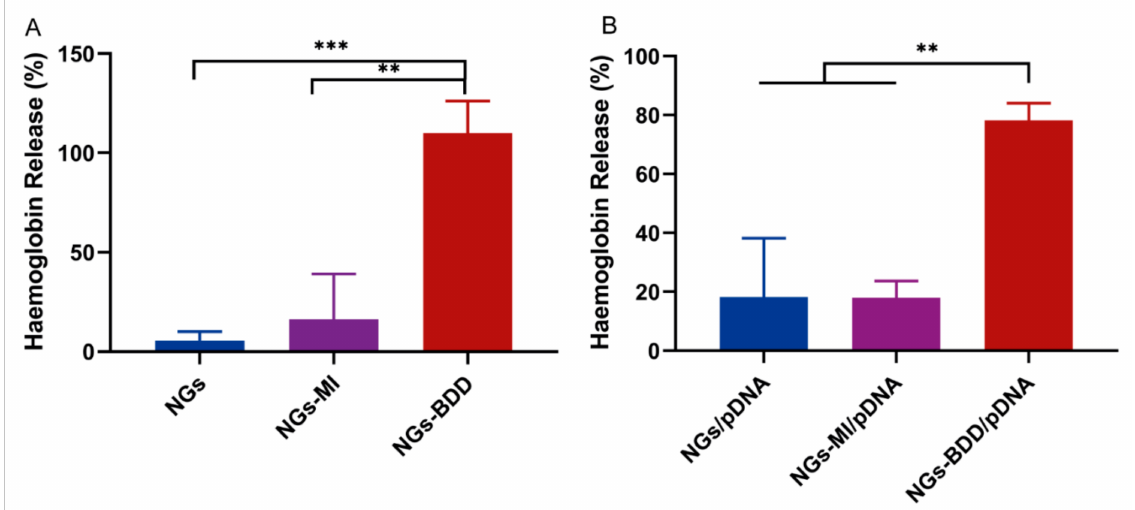
Figure 7. Membrane-perturbing activity of nanogels and their complexes with pDNA. Erythrocytes were incubated with ( A ) NG, NG-MI, and NG-BDD nanogels and ( B ) complexes, and hemoglobin release was measured by absorption spectroscopy. 100% hemoglobin release was induced with 1% Triton X-100 ( n = 3, ** p < 0.005 *** p <